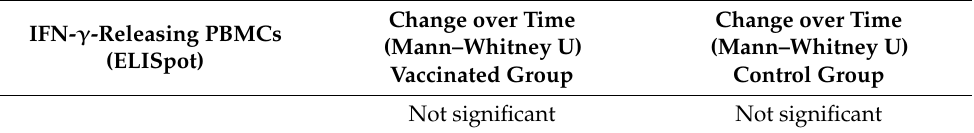
Table A9. Results of the Friedman and Dunn’s post test of IFN- γ -releasing PBMCs in vaccinated and control after stimulation with FCV 27 after FCV Challenge